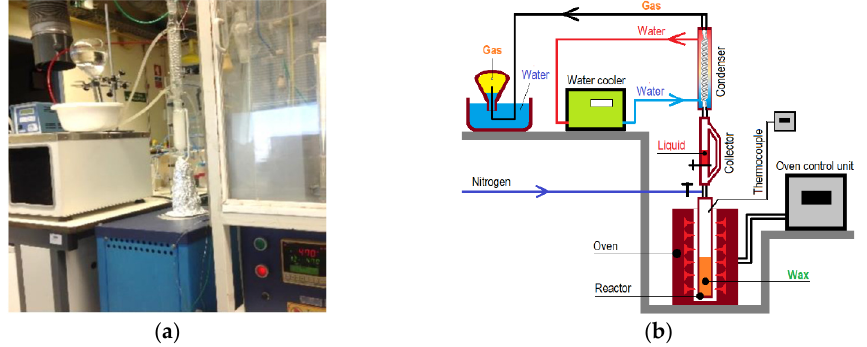
Figure 1. DL—DEQ—IST thermal pyrolysis: ( a ) reactional system; ( b ) schematic diagram.